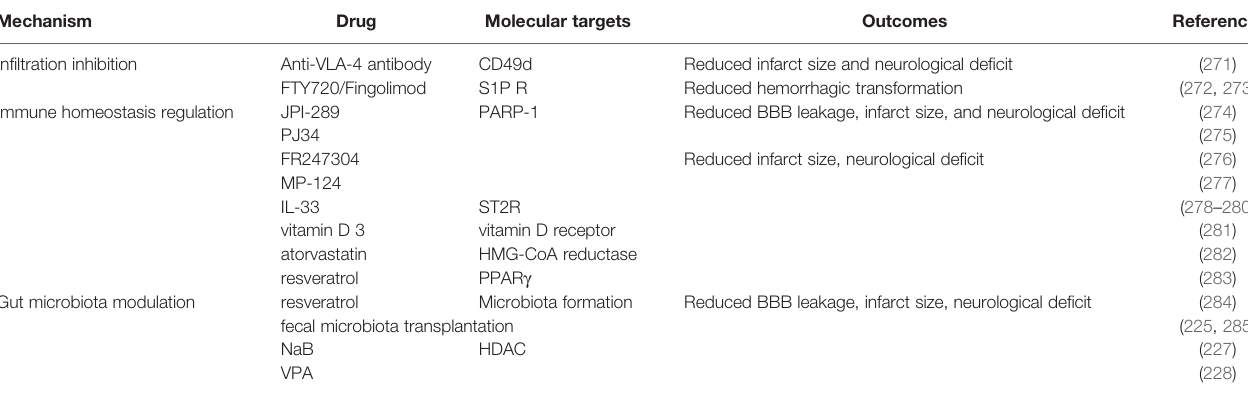
TABLE 4 | Preclinical attempts to target T lymphocytes for treating